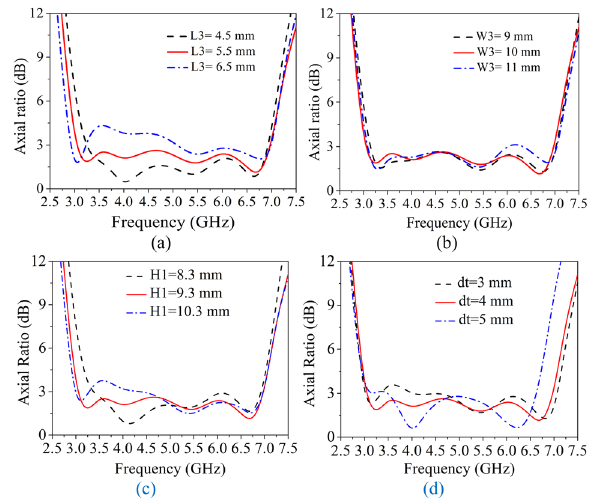
Figure 7. Simulated ARs for different parameters. ( a ) L3, ( b ) W3, ( c ) H1, and ( d ) dt.